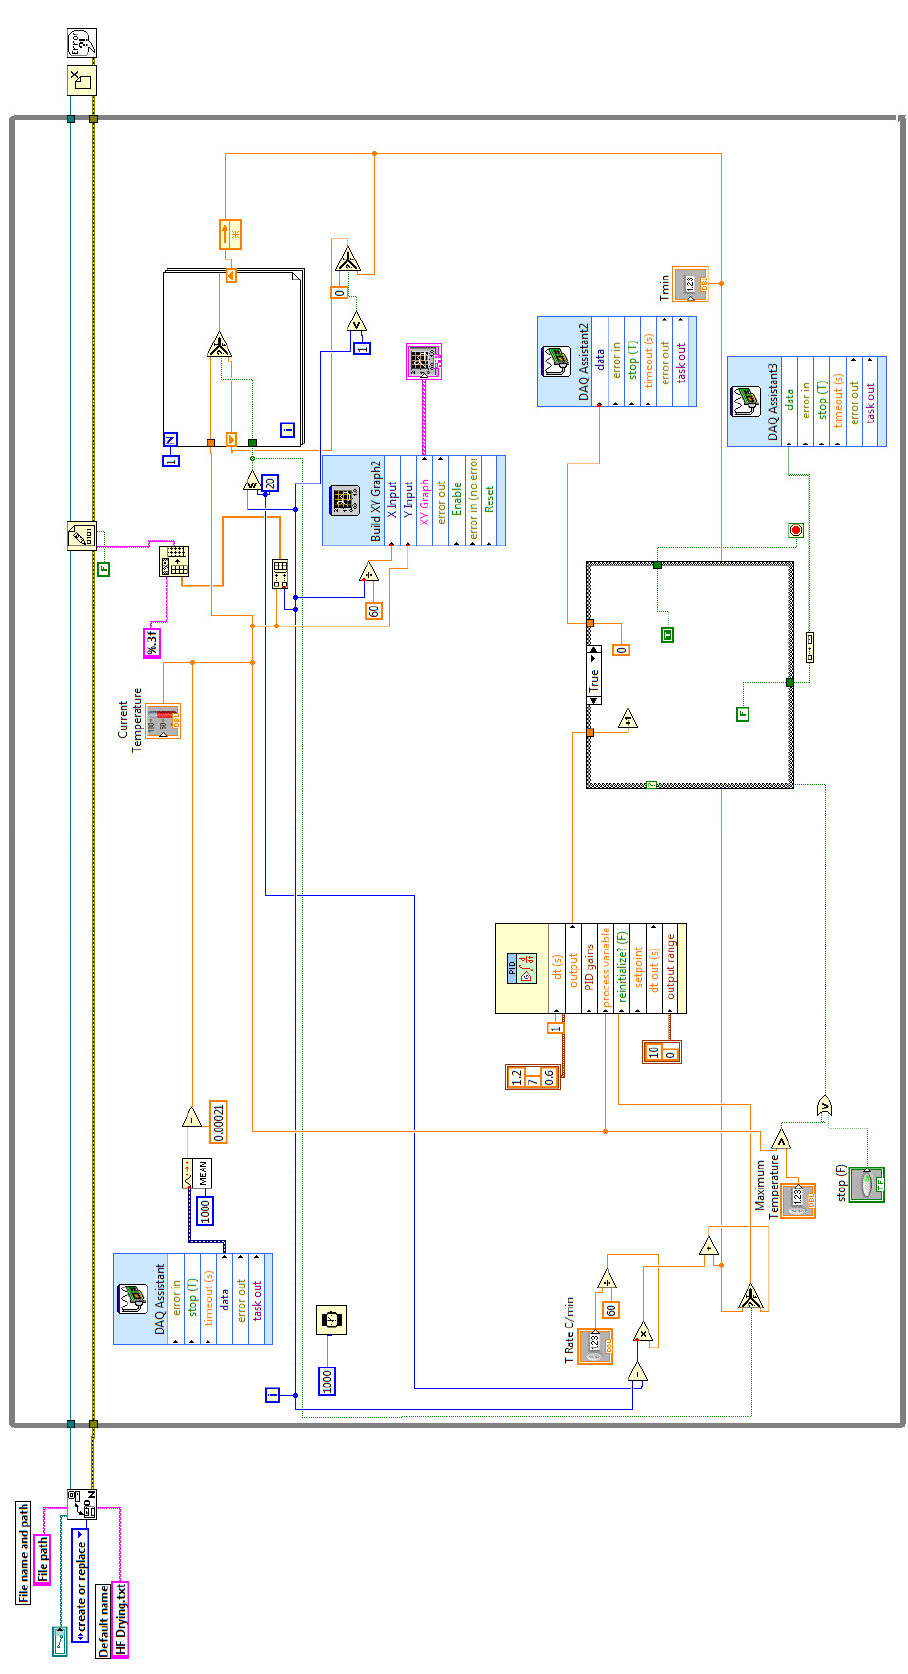
Figure 7. Application block diagram.